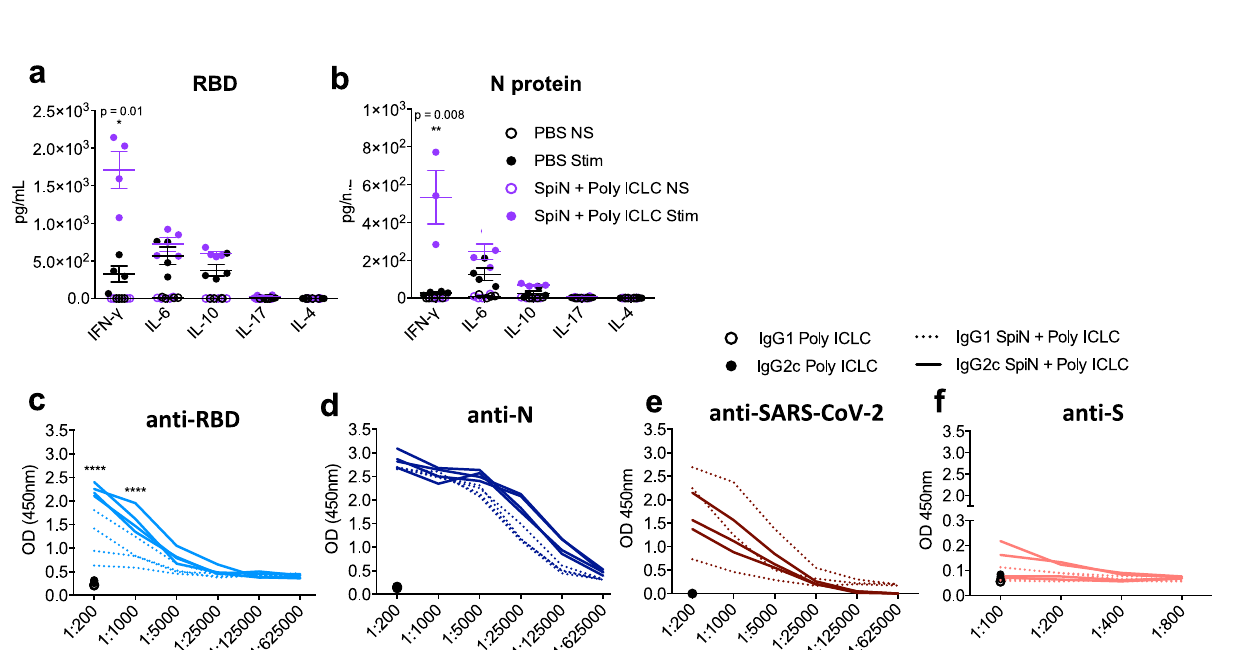
Fig. 2 | Evaluation of immune response and protection elicited by vaccination with RBD, N or SpiN proteins associated with Poly ICLC. a Immunization pro- tocol used in the experiments shown in Figs. 2 – 8 to analyze the immune response andprotectionagainstSARS-CoV-2.Antigen-speci fi cIgGantibodiesweremeasured in the bronchoalveolar lavage (BALF) at 1:1 ( b ) and serially diluted sera from immunized mice ( c ). Levels of IFN γ ( d ) and IL-10 ( e ) were measured on culture supernatant of splenocytes stimulated with RBD or N antigens. b-e , n =3/group. f , g Body weight and survival of K18-hACE2 mice immunized with RBD, N or SpiN associated with Poly ICLC and challenged with the Wuhan strain of SARS-CoV-2. h , i Viralload,measuredbyRT-PCR,inthelungandbraintissuesfromunvaccinated andmicevaccinatedwitheitherRBD,N,orSpiNassociatedwithPolyICLC. f – i n =4/ group. j , k LevelsofcirculatingtotalIgGspeci fi cforeitherN,RBDandSproteinsor inactivated SARS-CoV-2 in mice immunized with SpiN ( n =4/group) . l , m Total IgG responseofconvalescentindividualstoeitherNorRBDandinactivatedSARS-CoV-